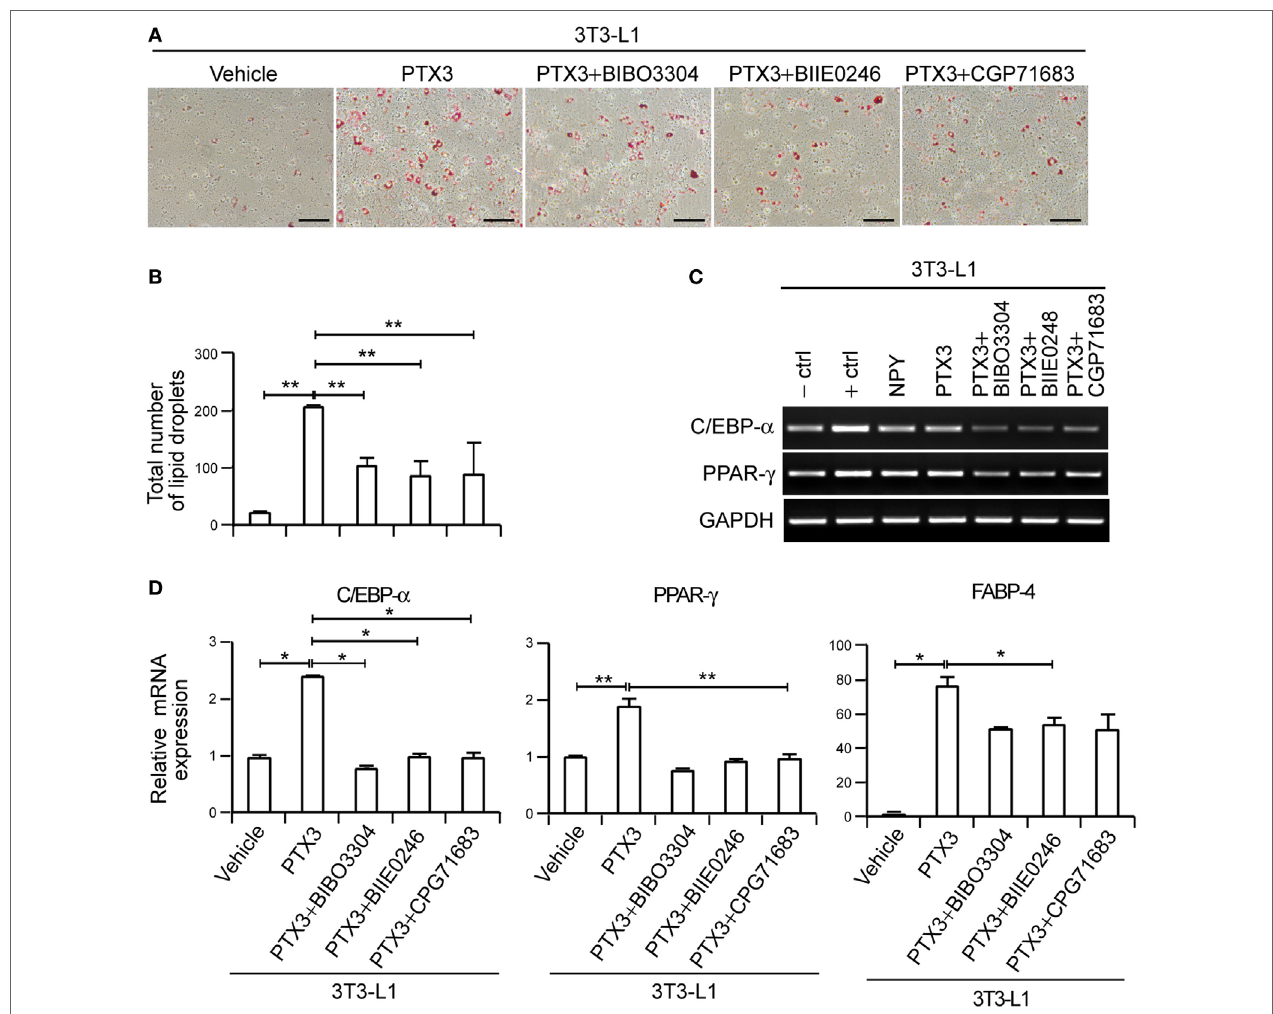
FigUre 5 | Pentraxin 3 (PTX3)-induced adipogenesis is mediated by neuropeptide Y/NPYR signaling in murine preadipocytes. (a) 3T3-L1 preadipocytes were cultured in medium supplemented with a differentiation cocktail for 2 days and then treated with PTX3 (200 ng/ml) with or without NPY1R antagonist (BIBO3304), NPY2R antagonist (BIIE0246), or NPY5R antagonist (CGP71683 hydrochloride) for an additional 4 days without insulin. The cells were fixed, stained with Oil-Red-O, and imaged under a microscope. Scale bar: 100 microm (µM). (B) Quantification of the total number of lipid droplets in (a) ( n = 5). (c) PTX3 modulates the expression of adipogenesis-associated transcription factors in murine preadipocytes. Adipocytes were treated with PTX3 (200 ng/ml) with or without NPY1R antagonist (BIBO3304) (1 µM), NPY2R antagonist (BIIE0246) (1 µM), or NPY5R antagonist (CGP71683 hydrochloride) (1 µM). Total RNA was isolated from 3T3-L1 preadipocytes, and C/EBP- α and peroxisome proliferator-activated receptor γ (PPAR- γ ) levels were determined by RT-PCR. (D) PTX3 upregulates the expression of adipocyte differentiation markers via NPYR signaling. C/EBP- α , PPAR- γ , and fatty acid binding protein-4 expression levels in cells from (a) were determined using quantitative real-time PCR (qPCR). The qPCR data are the fold-changes of the mean vehicle control value ( n = 4). Data are representative of more than two independent experiments. * p < 0.05 and ** p < 0.005 compared with the vehicle control. p values were calculated using Kruskal–Wallis test. Data values represent the mean ±